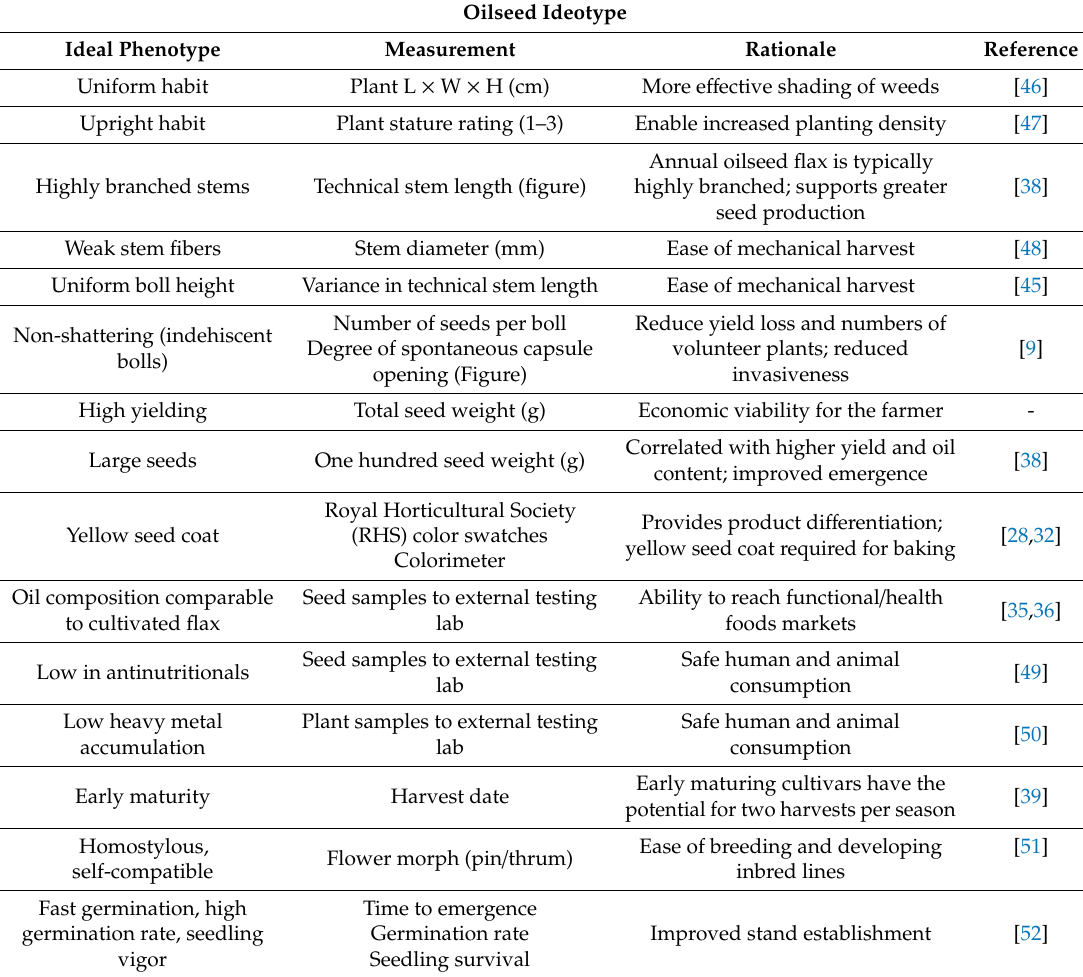
Table 1. The proposed perennial flax oilseed ideotype including the ideal phenotypes, their measurement, and rationale for the choice of